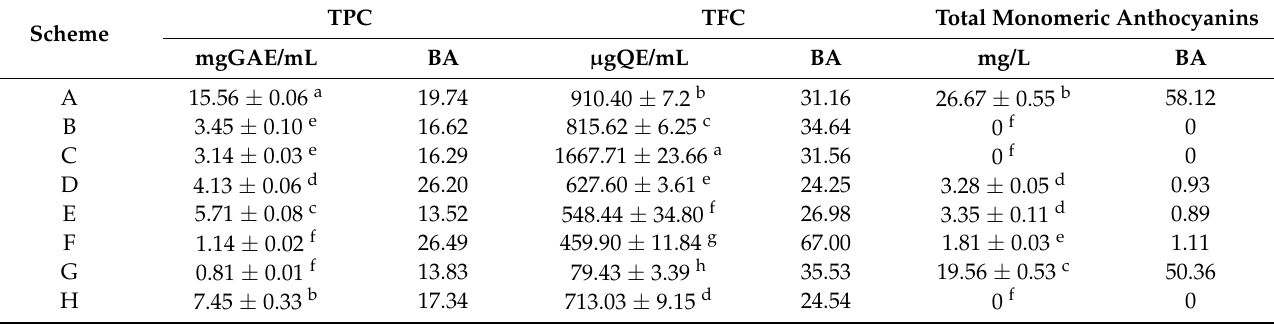
Table 4. Bio-accessibility (BA, %) of phytochemicals after in vitro digestion *.